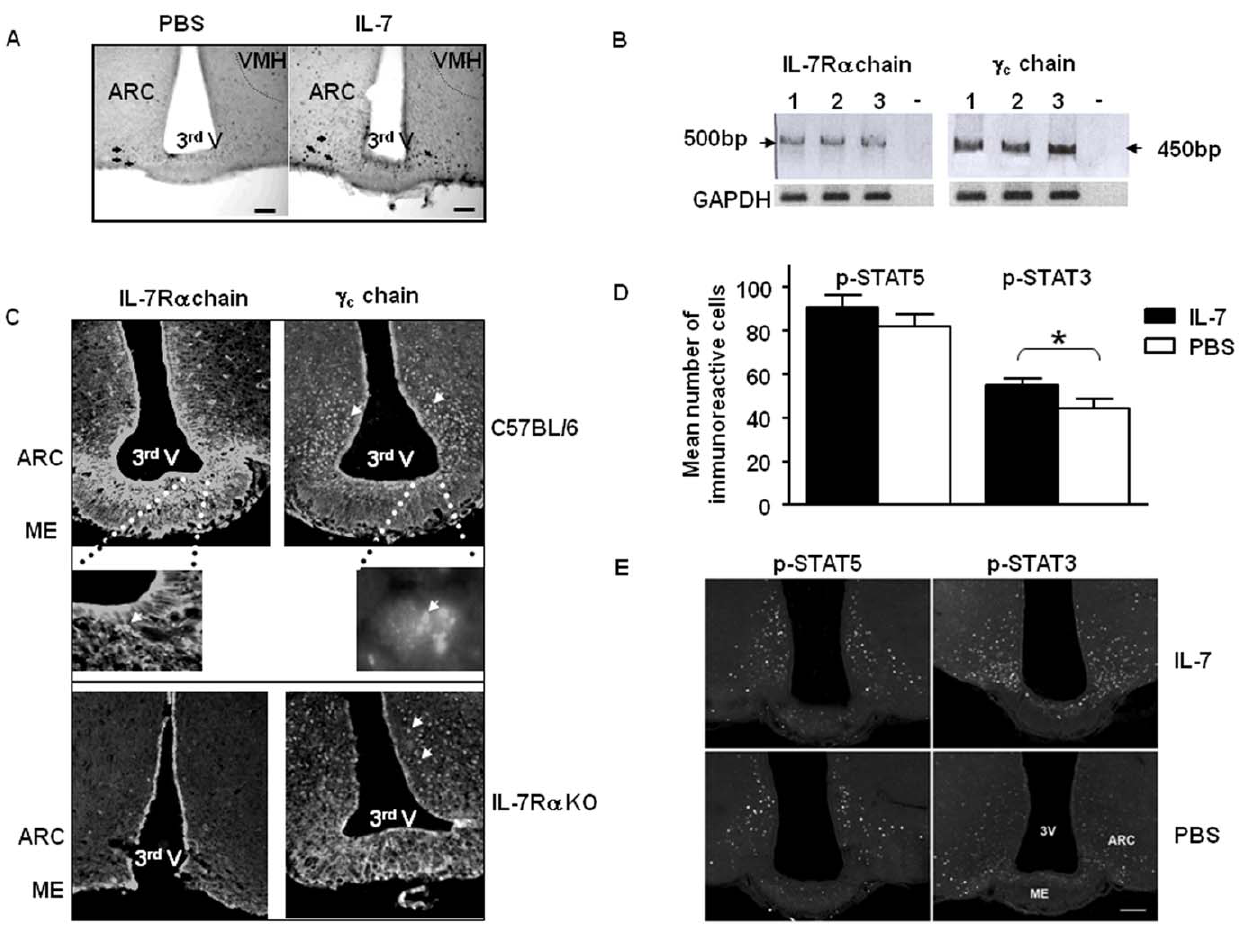
Figure 3. IL-7 activates hypothalamic cells and IL-7 receptor is expressed on hypothalamic cells. ( A ) Representative microphotographs of Fos expression induced by peripheral IL-7 injection in C57BL/6 mice. Fos-immunoreactive cells in arcuate nucleus (ARC) in PBS-treated and IL-7- treated mice. Arrows indicate Fos-imunoreactive cells. 3 rd V: third ventricule; VMH: ventromedial hypothalamic nucleus. Scale bars represent 100 m m. ( B ) mRNA expression of IL-7R a and c c chains in the whole hypothalamus of 2-month-old C57BL/6 mice (n=3). Lanes (1, 2, 3) represent one animal. The - lane represents the negative control i . e . without retro-transcription. ( C ) Representative microphotographs of frontal hypothalamic frozen sections from 2-month-old mice showing fluorescent immunostaining of IL-7R a and c c chains in the arcuate nucleus. Frozen section from IL-7R a KO were used as control for the IL-7R a specific staining. ARC: arcuate nucleus, ME: median eminence, 3 rd V: third ventricule; VMH: ventromedial hypothalamic nucleus. ( D ) Mean number of phosphorylated (p)-STAT5 and p-STAT3 immunoreactive (IR) cells in the hypothalamic arcuate nucleus of C57BL/6 mice injected with recombinant IL-7 ( & ; n=5) or with PBS ( % ; n=5). Results are expressed as mean of immunoreactive cells 6 SEM per animal and per slice. * p , 0.05. ( E ) Representative microphotographs of p-STAT5 and p-STAT3-IR cells in the ARC in PBS-treated and IL-7-treated mice. Scale bar represent 100 m m. ARC: arcuate hypothalamic nucleus; ME: median eminence; 3rd: third ventricle.